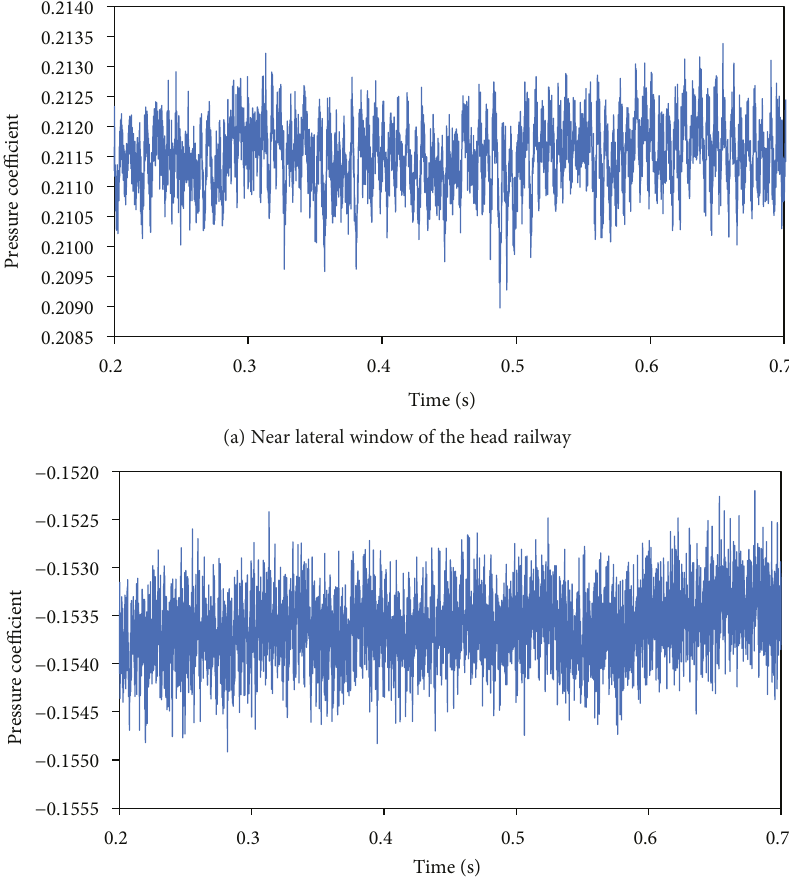
Figure 7: Comparison of pressure coe ffi cients at di ff erent points of high-speed